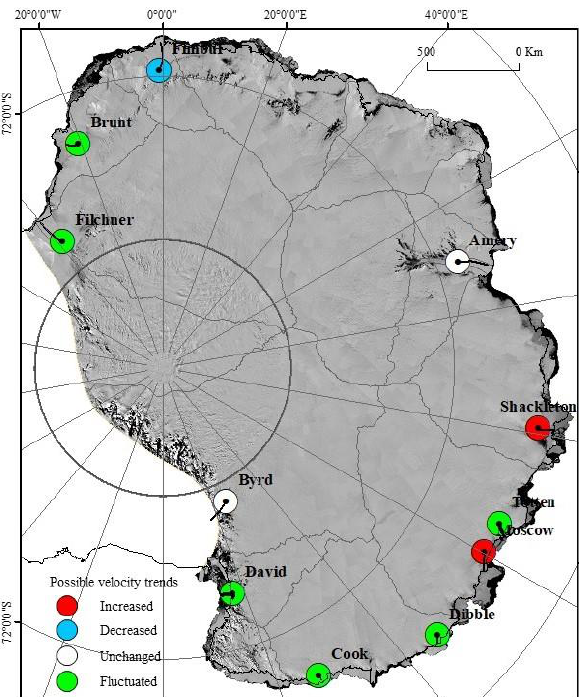
Figure 4. Potential velocity trends from 1963 to 2016,